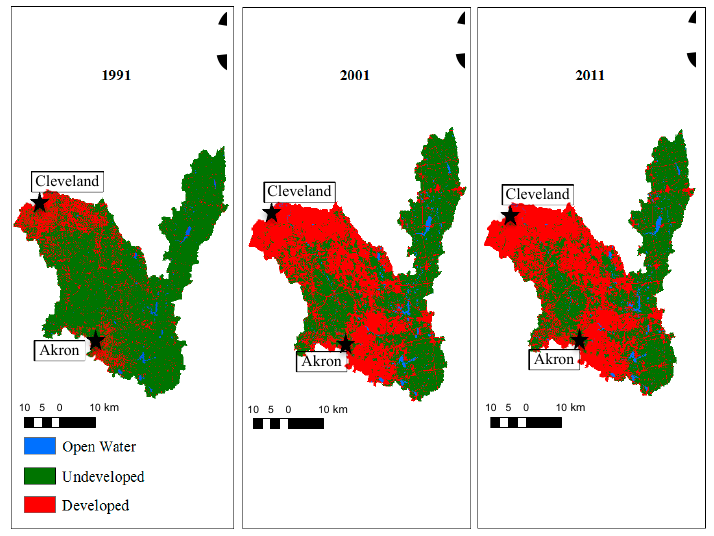
Figure 6. Land classification showing land change from 1991 to 2011.